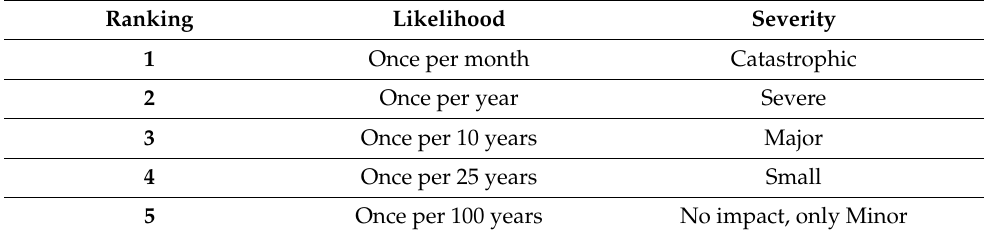
Table 2. Parameters for a risk-matrix.